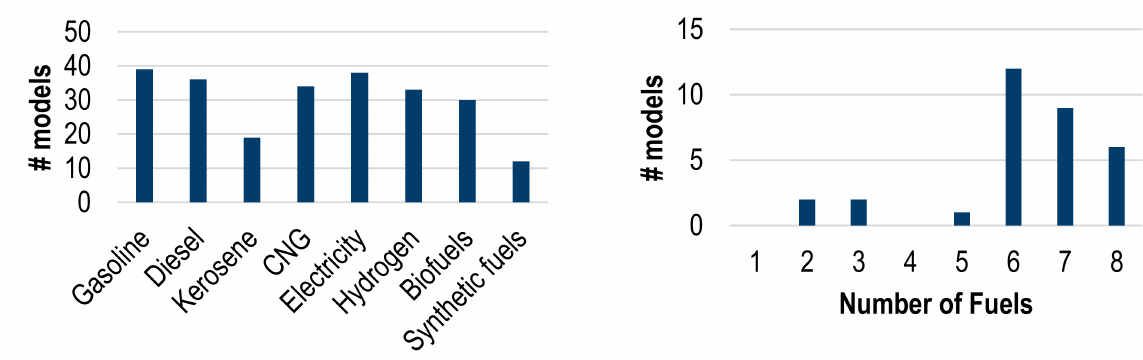
Figure A4. Fuels in transport sector